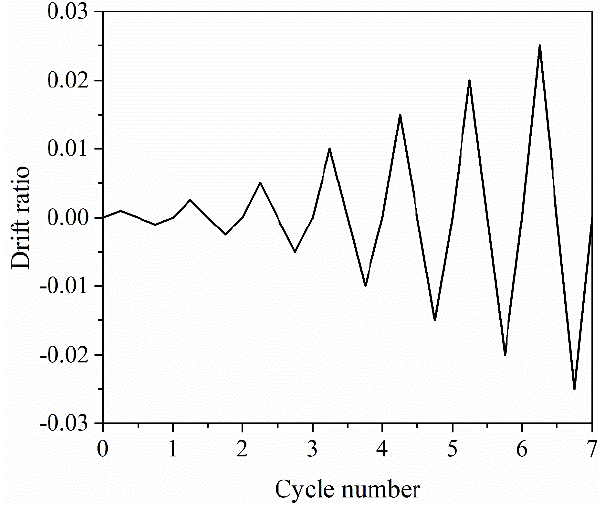
Figure 5. Loading patterns.